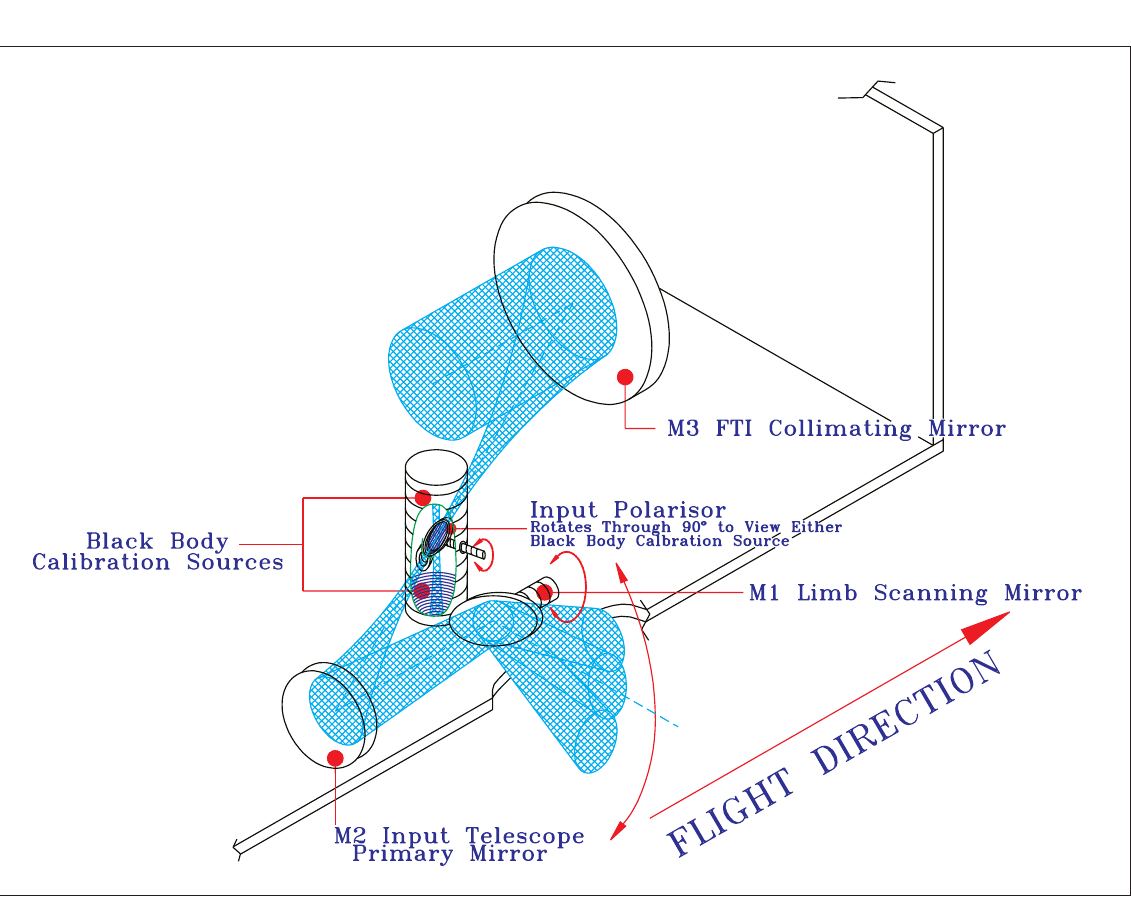
Fig. 6. Schematic of the SAFIRE-A input optics.